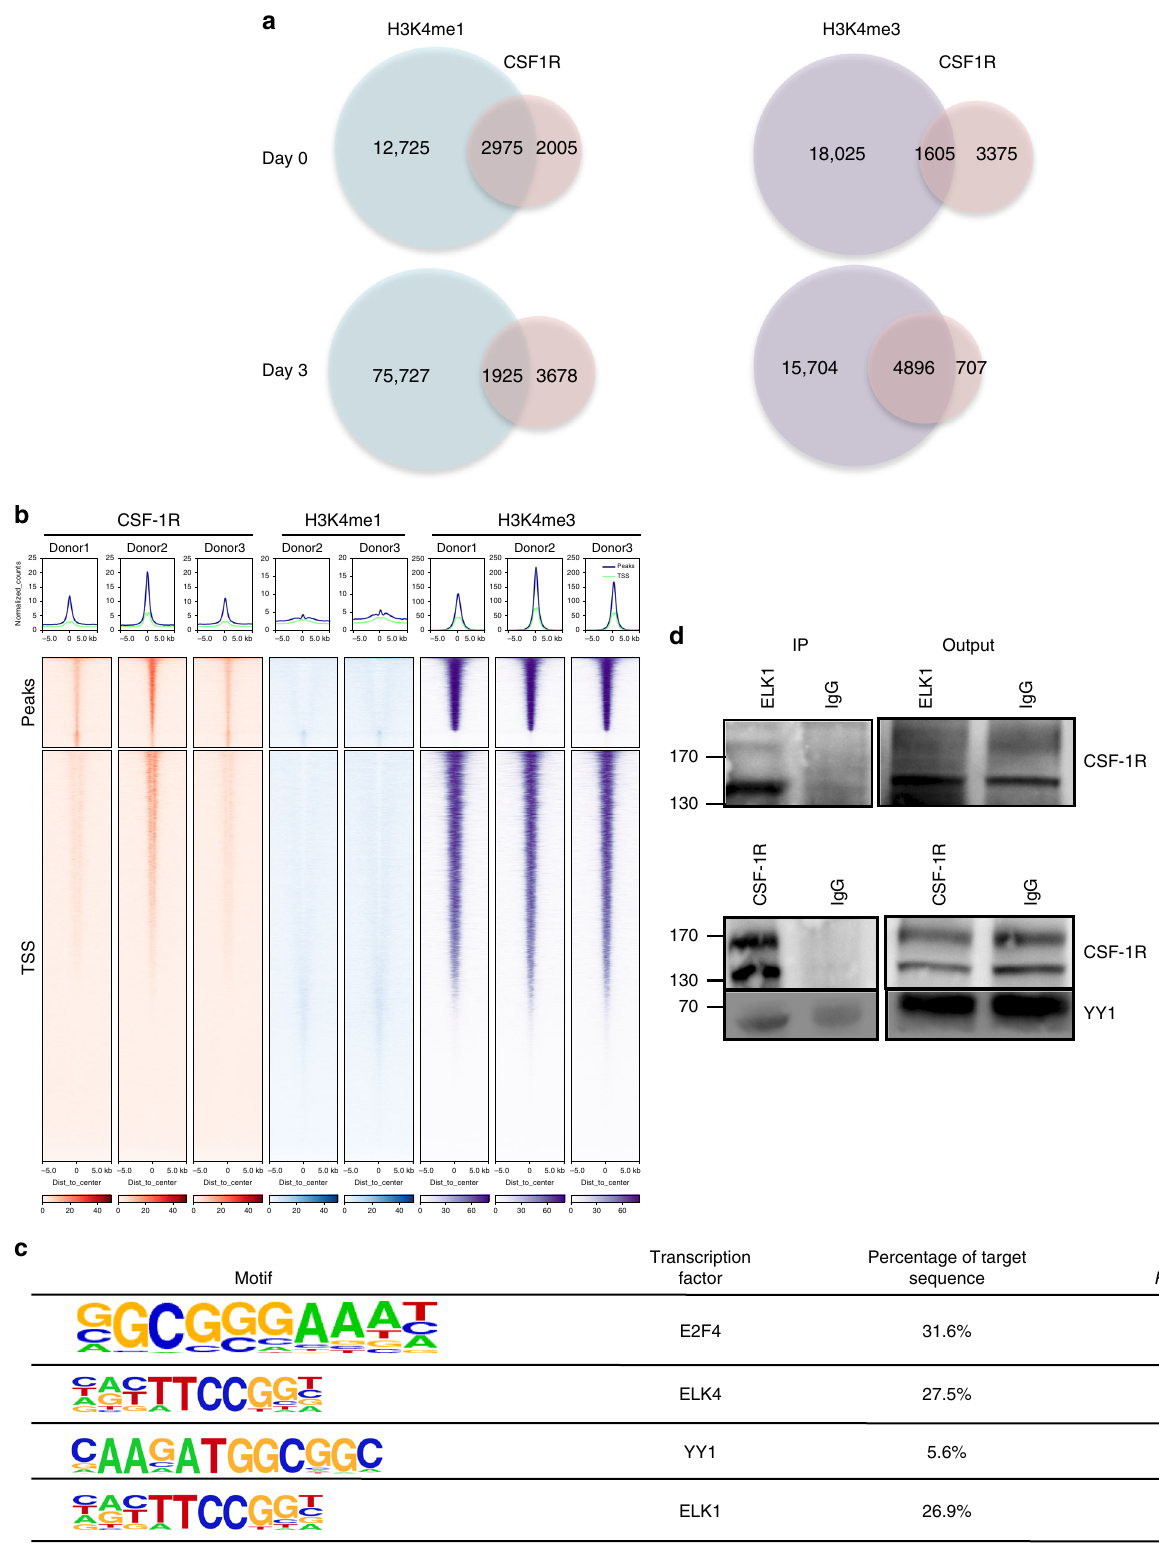
Fig. 7 Differential CSF-1R chromatin localization in CSF-1-induced macrophages. a Venn diagram of ChIP-seq peak number in untreated monocytes (Day 0) and monocytes treated with 100 ng/mL CSF-1 for 3 days (Day 3) showing peaks common to the 3 donors. Left: CSF-1R and H3K4me1 peaks; right: CSF-1R and H3K4me3 peaks. b Ranking heatmap centered on CSF-1R peaks (top) and on gene transcription starting sites (TSS) of CSF-1R, H3K4me1 and H3K4me3 peaks in CSF-1-differentiated macrophages (3 days 100 ng/mL). c Motif analysis of ChIP-seq experiment on 3 day CSF-1 differentiated monocytes (100 ng/mL). d Co-immunoprecipitation of CSF1R and ELK1 (upper panel) or YY1 (lower panel). Immunoprecipitation (IP) was performed with an anti-ELK1 (sc-365876) or anti-CSF-1R (sc-365719) and a control IgG in monocytes treated for 3 days with 100 ng/mL CSF-1, followed by immunoblotting with an anti-CSF-1R ( n = 2 each) or an anti-YY1 ( n = 3)